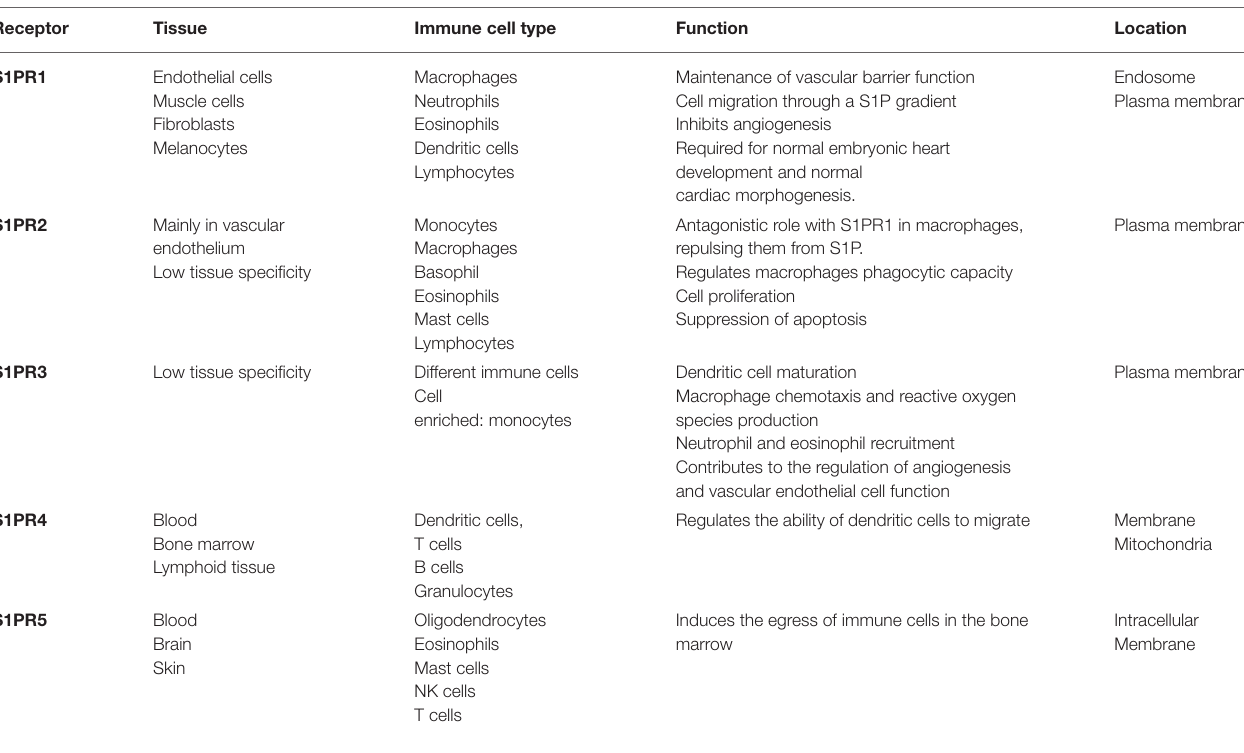
TABLE 1 | An overview of sphingosine-1-phosphate (S1P)